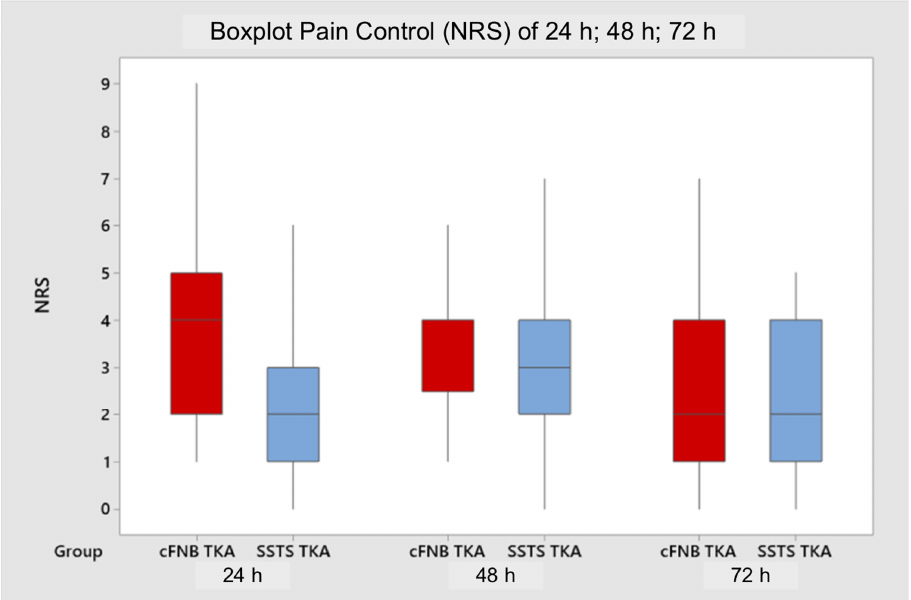
Figure 3. Boxplot analysis of pain control at 24 h, 48 h, and 72 h between the two groups. Horizontal line represents mean value, and the square box represents interquartile range.